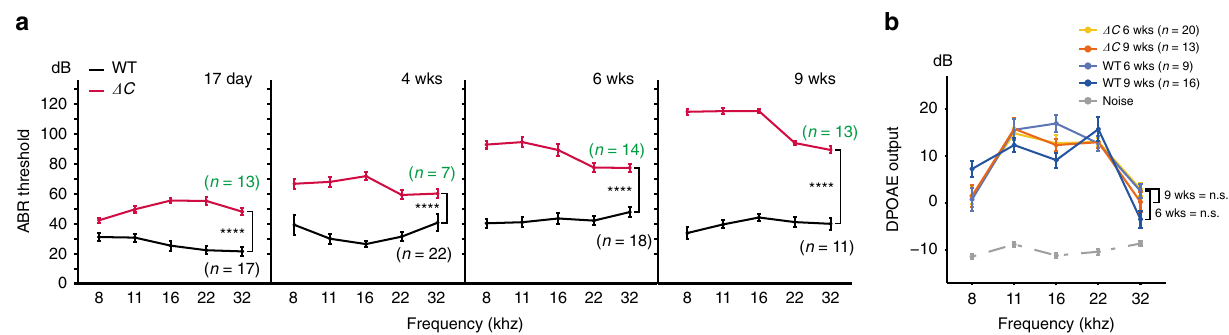
Fig. 7 Progressive hearing loss in Myo7a- Δ C mice. a ABR thresholds in Myo7a- Δ C and age-matched WT controls. Threshold differences increase progressively with age. p values for 17 days = 3.38e − 29, 4 weeks = 1.62e − 21, 6 weeks = 5.68e − 44, and 9 weeks = 2.22e − 54 (two-way ANOVA between Myo7a- Δ C and age-matched WTs). b No signi fi cant difference in DPOAE output between WT and Myo7a- Δ C. p values for 4 weeks = 0.69 and for 9 weeks = 0.83 (two-way ANOVA between Myo7a- Δ C and WT ) . Error bars indicate standard error of the mean and n = number of